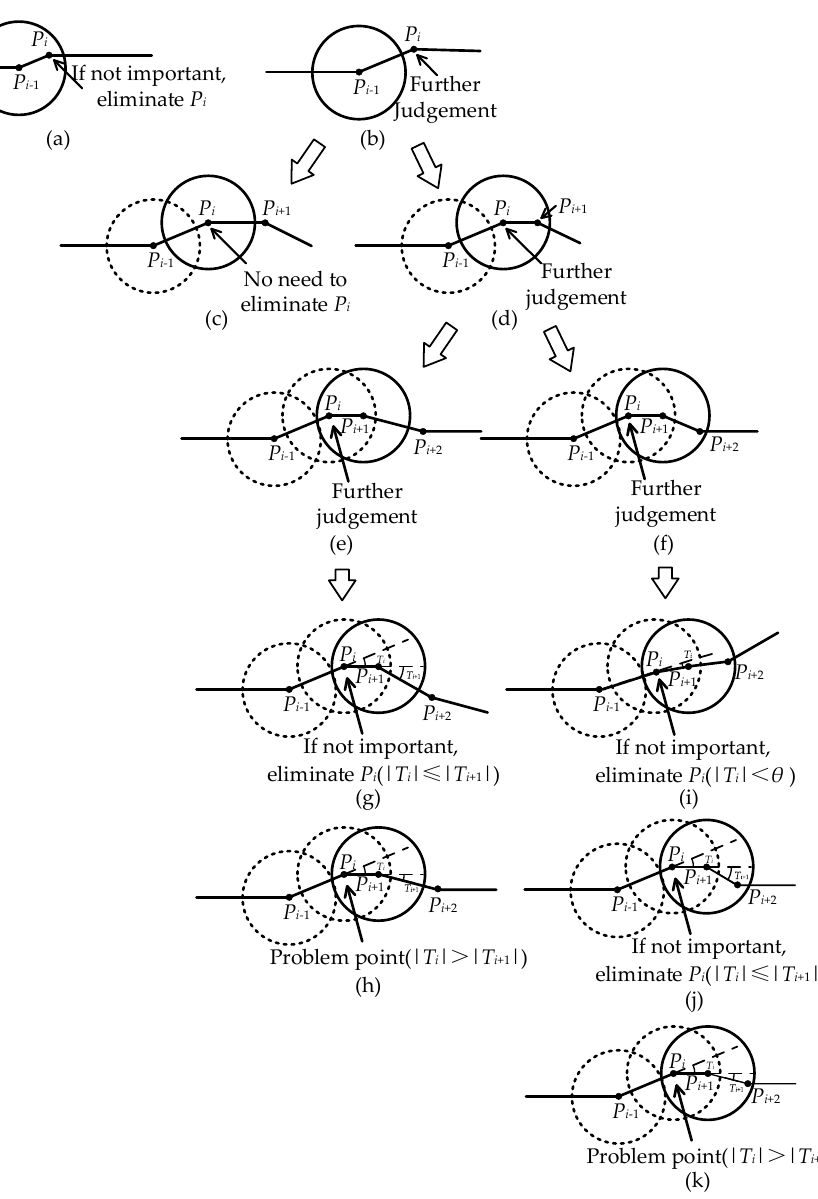
Figure 11. Vertex elimination on a curved road. ( a ) D i , 1 < ε ; ( b ) D i , 1 ≥ ε ; ( c ) D i , 1 ≥ ε and D i , 2 ≥ ε ; ( d ) D i ,